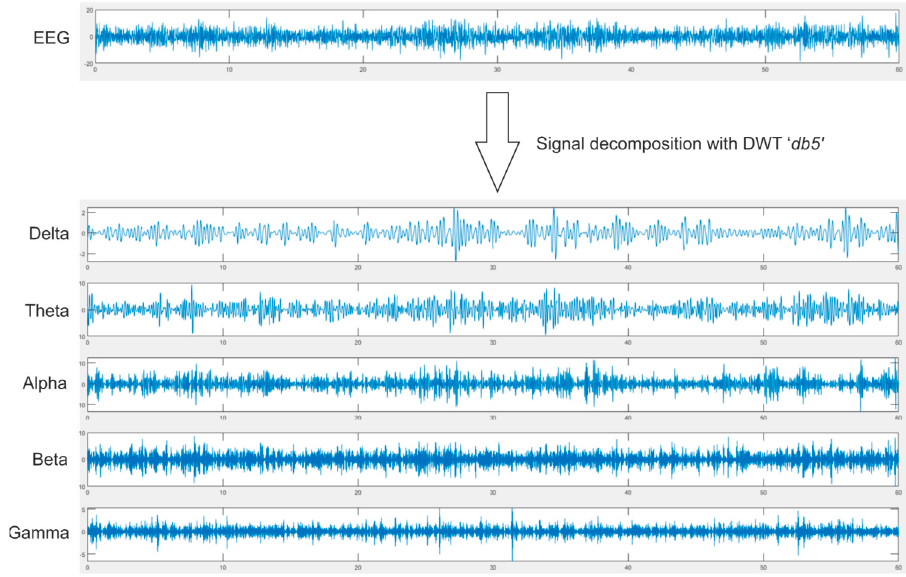
Figure 2. Decomposition of the EEG signal in sub bands with Discrete Wavelet Transform using ‘db5 ′ mother wavelet.